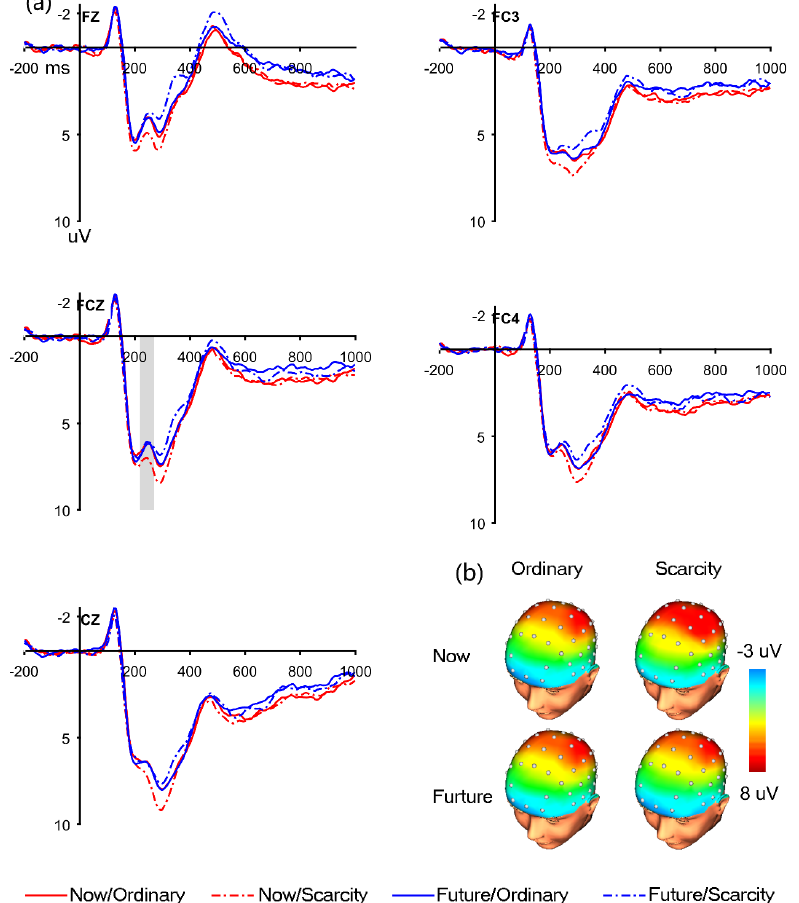
Figure 2. Shows the grand averaged waveforms of FRN. In panel ( a ), electrode points were selected as Fz, FC3, FCz, FC4, and Cz. The solid red line is Now/Ordinary, the dash − dotted red line is Now/Scarcity, the solid blue line is Future/Ordinary, and the dash − dotted blue line is Future/Scar- city. The shadow of the FCZ indicates FRN, and the time point is 220 ms − 270 ms. The average am- plitude (uV) of 220 ms − 270 ms was selected for the EEG topographic map in panel ( b ). The grand average of dFRN and topography maps of ordinary and scarcity are illus- trated in Figure 3. The main effects of the reward type was significant (F(1, 43) = 4.812, p = 0.034, part. η 2 = 0.101), and more negative dFRN was associated with the scarcity condition than the ordinary condition (0.028 ± 2.53 uV vs. − 0.926 ± 0.299 uV).